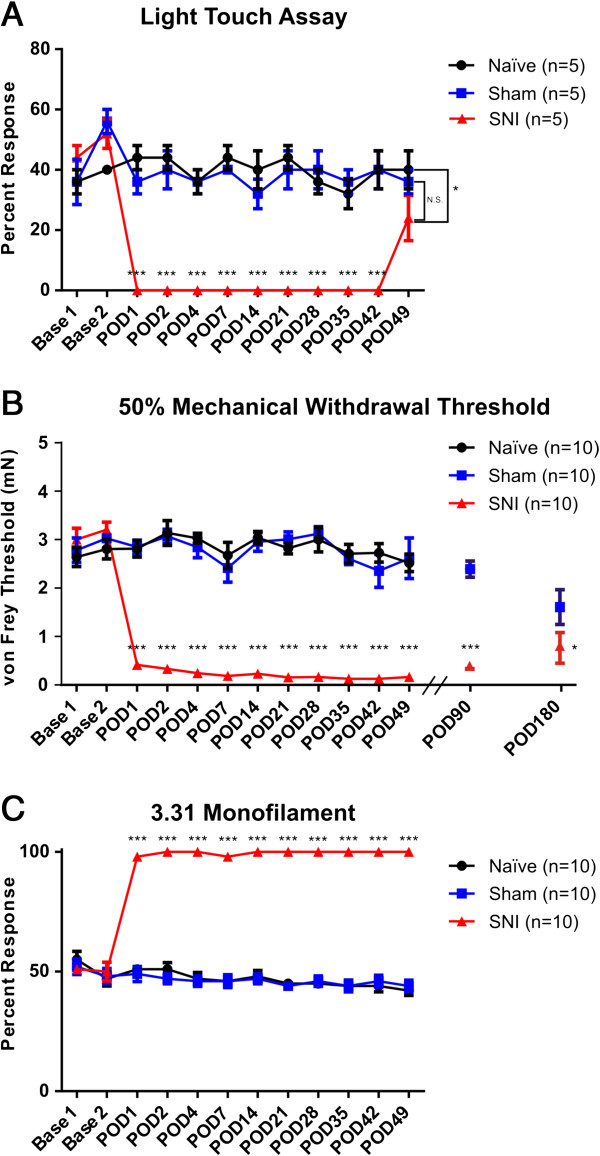
SNI mice exhibit prominent behavioral hypersensitivity. A) In response to dynamic stroke of a puffed cotton swab, SNI mice show significant desensitization of the tibial territory beginning POD 1 and continuing through POD 42 compared to sham or naïve animals (***p<0.005). At POD 49 SNI mice begin to regain sensation in the tibial territory, in that SNI mice still showed some sensitization compared to naïve animals (*p<0.05) but not sham animals (p>0.05). Treatments were compared across time using a repeated measure 2-way ANOVA with Tukey’s post hoc comparisons. B) SNI mice show a significant decrease in the 50% mechanical withdrawal threshold beginning POD 1 and continuing through POD 49 compared to sham or naïve mice (***p<0.005). Furthermore, SNI mice continue to show a significant decrease in mechanical withdrawal threshold at POD 90 compared to sham (***p<0.005) and at POD 180 compared to sham (*p<0.05). Treatments were compared across time using a 2-way ANOVA with Bonferroni post hoc tests. SNI and sham treatments were compared at POD 90 and POD 180 using Mann–Whitney U tests. C) In response to repeated stimulus with a 3.31 mN monofilament, SNI mice exhibit prominent hypersensitivity beginning POD 1 and continuing through at least POD 49 compared to sham or naïve animals (***p<0.005). Treatments were compared across time using a 2 way-ANOVA with Bonferroni post hoc tests. Error bars for all three graphs indicate S.E.M.